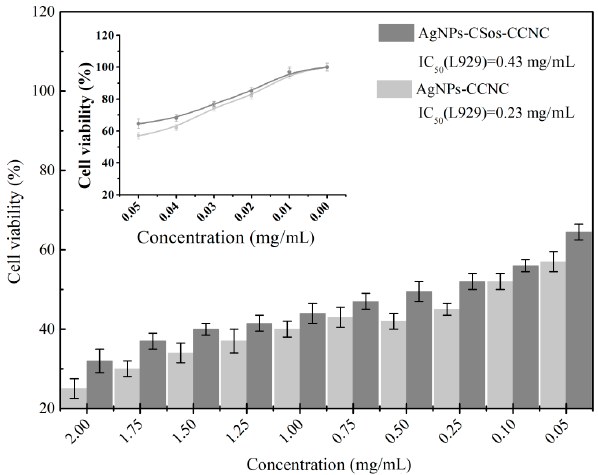
Figure 10. The cytotoxicity of the AgNPs-CSos-CCNC and the AgNPs-CCNC hybrid on L929 cells using the CCK8 assay.